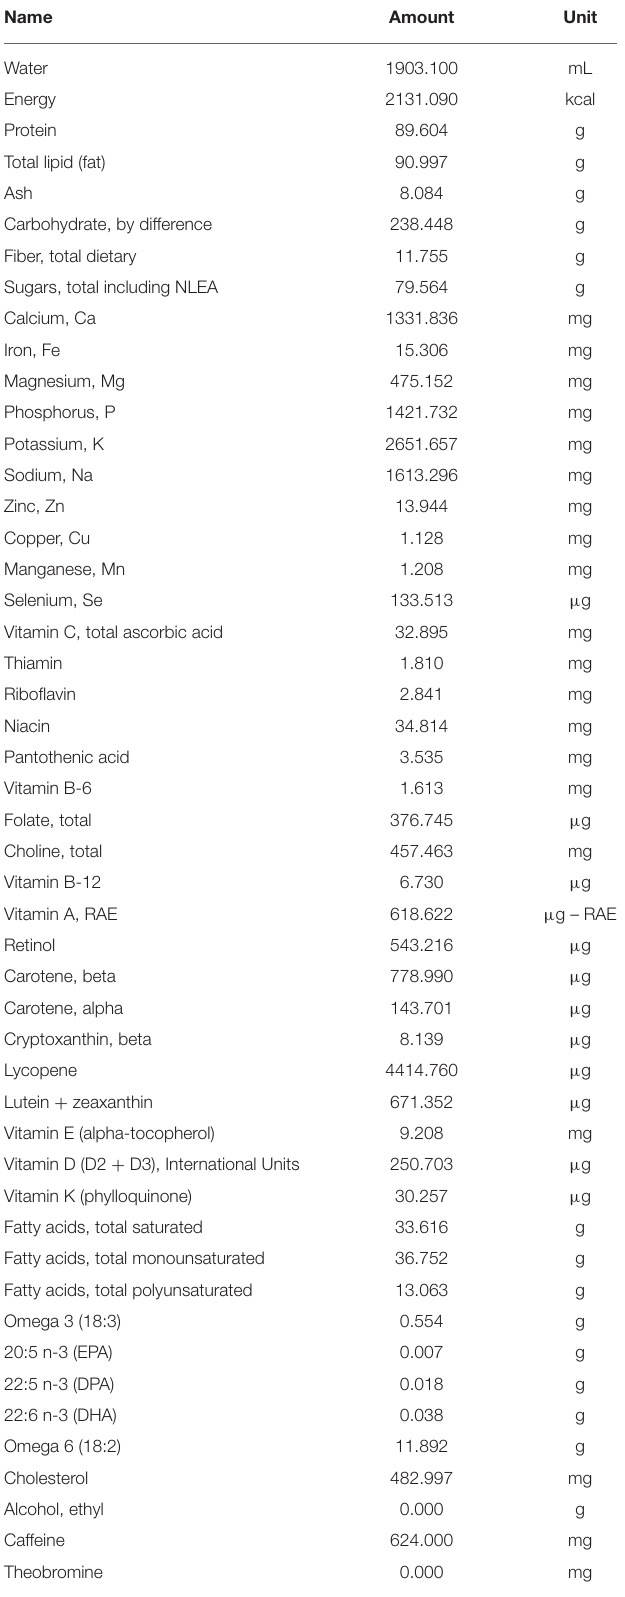
TABLE 1 | Example of nutrient totals report of a 24HR loaded into